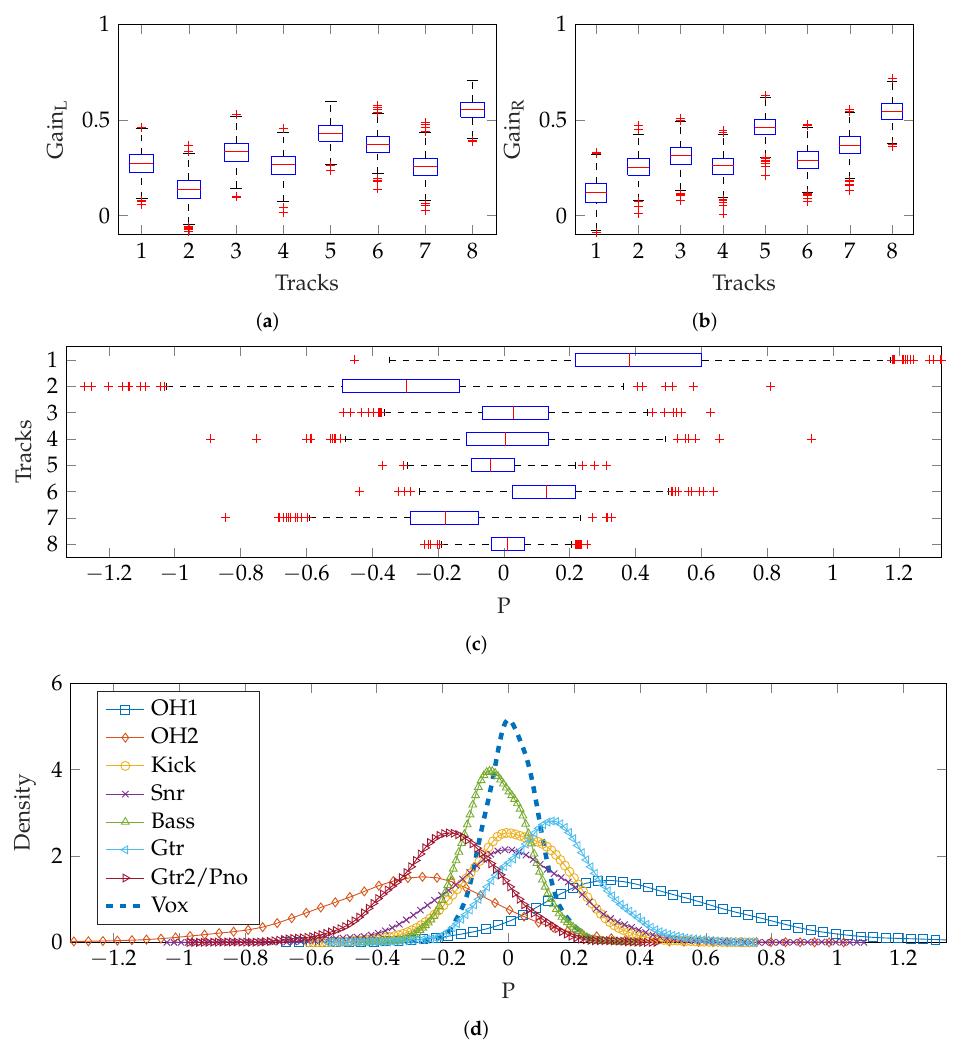
Figure 9. Panning method 1b—separate vMF distributions for left and right channels but using unique µ vectors, shown in Equations (10) and (11). ( a ) Boxplot of track gains for left channel, using Equation (10); ( b ) Boxplot of track gains for right channel, using Equation (11); ( c ) Boxplot of pan positions for each track. Where P | | > 1, this is caused by negative track gains; ( d ) Probability density of pan positions for each